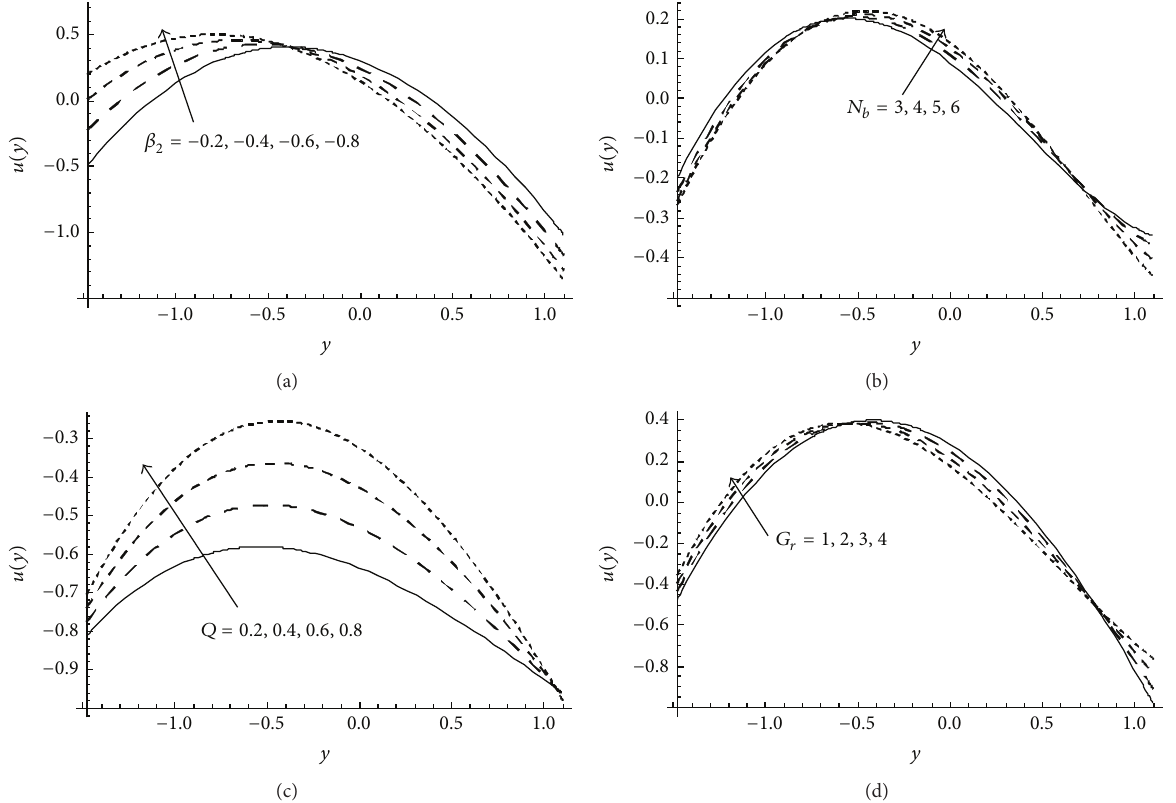
Figure 11: Variation of the velocity profile at 𝑎 = 0.1 , 𝑏 = 0.5 , 𝑑 = 1 , 𝐵 𝑟 = 0.5 , 𝑥 = 0.1 , 𝜙 = 0.2 , 𝛾 = 𝛾 1 = 0.5 , and 𝛽 1 = 0.1 for (a) 𝑁 𝑡 = 0.5 , = 0.8 , 𝐺 = 0.5 , 𝑄 = 2 , and 𝛽 𝑁 𝑏 𝑟 = 0.5 , 𝛽 = −0.2 , and 𝑄 = 0.2, 0.4, 0.6, 0.8 ; and (d) 𝑁 𝐺 𝑟 2